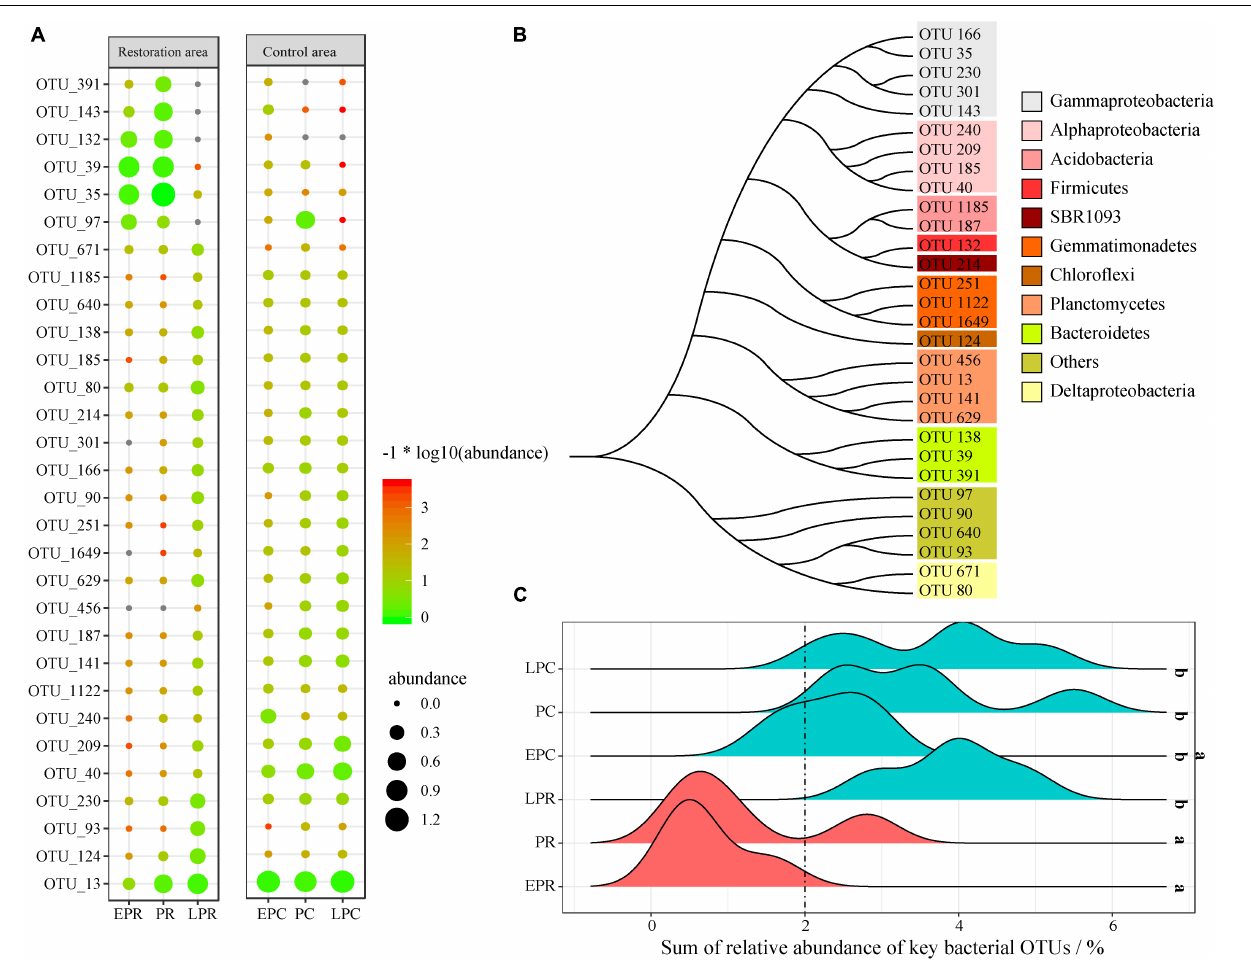
FIGURE 4 | The random forest (RF) model detects the key operational taxonomic units (OTUs) during the restoration time. (A) The fingerprint spectrum of key OTUs in different groups; (B) phylogenetic analysis of key OTUs; (C) the sum of relative abundance of key OTUs in different groups. a , b The different letters represent the significant difference ( p < 0.05). OrangeRed represents the samples during the degradation period. Cyan stands for samples of restoration success and control